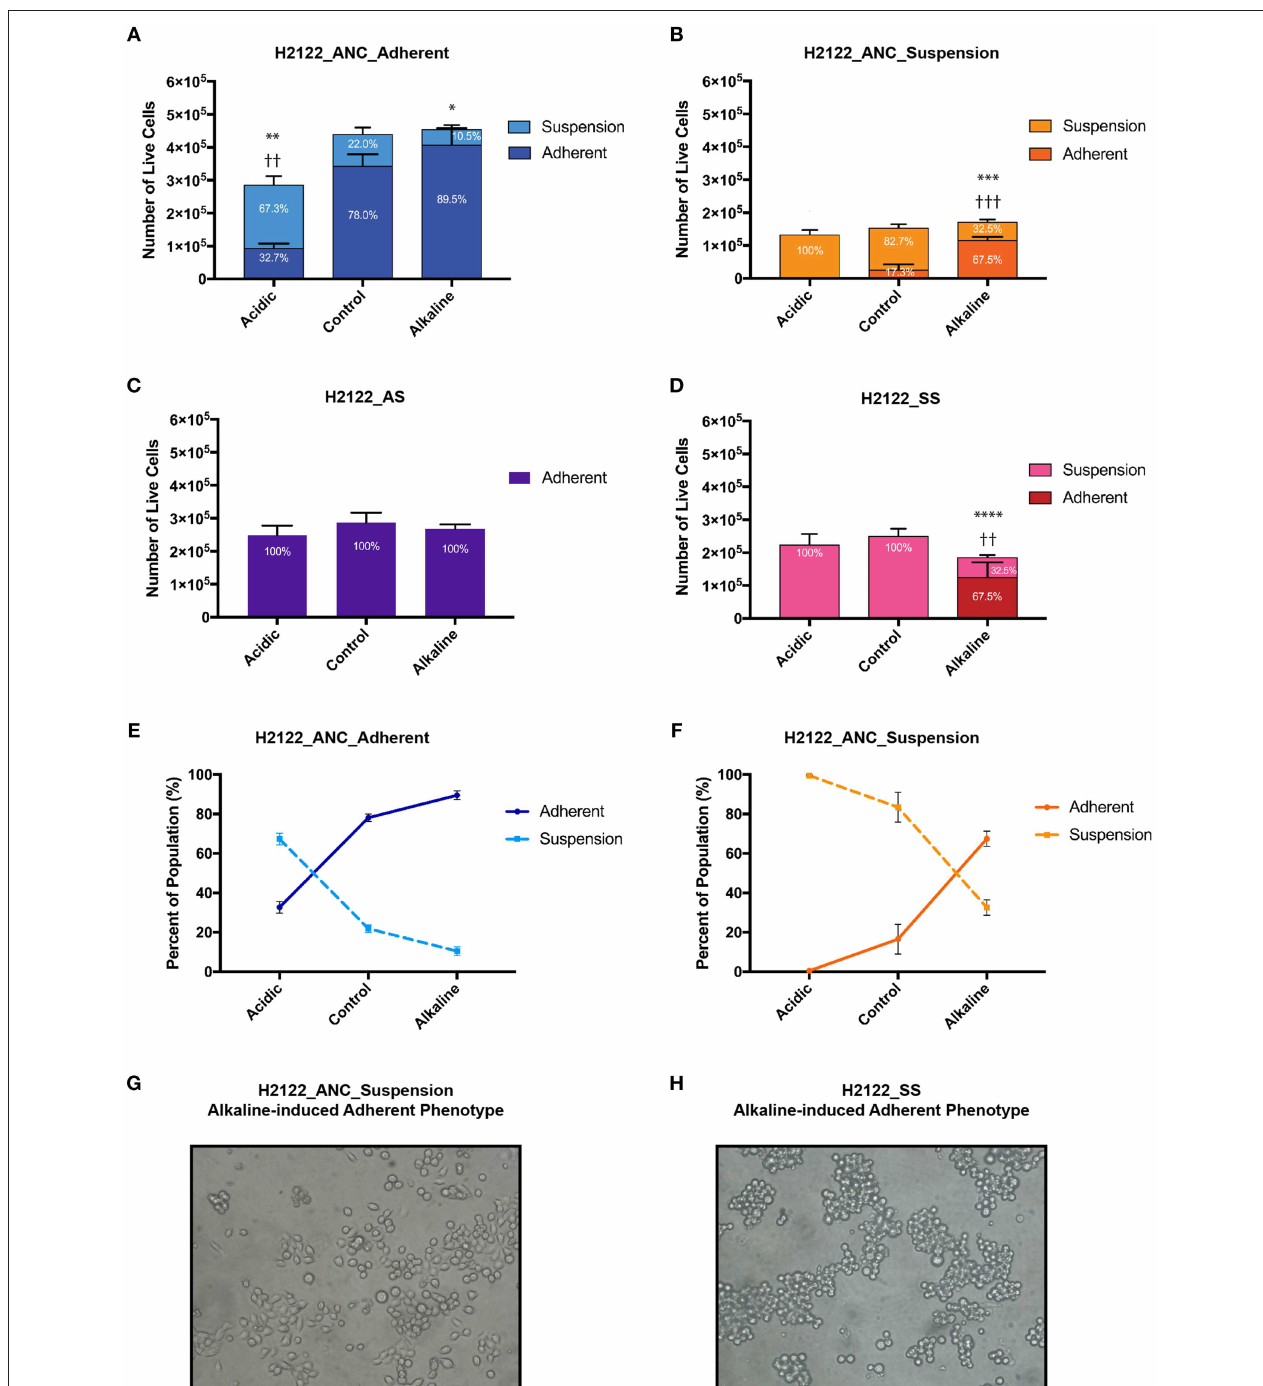
FIGURE 2 | The effect of extracellular pH on the size (as number of live cells) and phenotypic composition (as percentage of live cells in the adherent and suspension cell fractions relative to the entire population) of four genetically-related but phenotypically distinct cancer cell populations subjected for 24h to acidic (pH 6.4), control (pH 7.4), and alkaline (pH 8.4) media. (A) H2122_ANC_Adherent Population. (B) H2122_ANC_Suspension Population. (C) H2122_AS line. (D) H2122_SS line. (E,F) Changes in the proportion of the suspension and adherent fractions in the Adherent and Suspension populations of the ANC line, as a function of pH [data are from (A,B) ]. (H) Attached H2122_SS cells exhibit round morphology following treatment with alkaline media; (G) Attached H2122_ANC_Suspension cells exhibit a mixture of round and epithelial-like morphology following treatment with alkaline media. All treatments were performed in 1.5ml media, with 3 biological